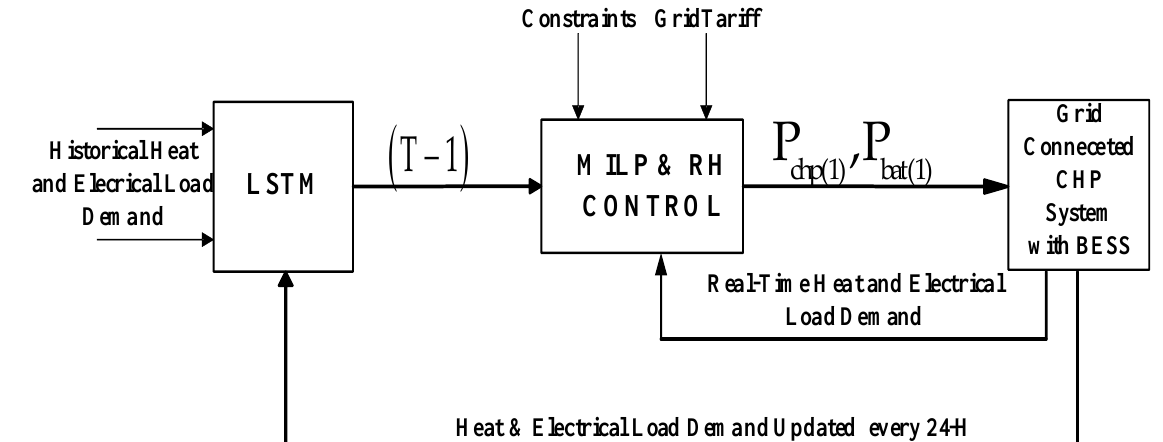
Figure 4. Illustration of the RH control strategy.